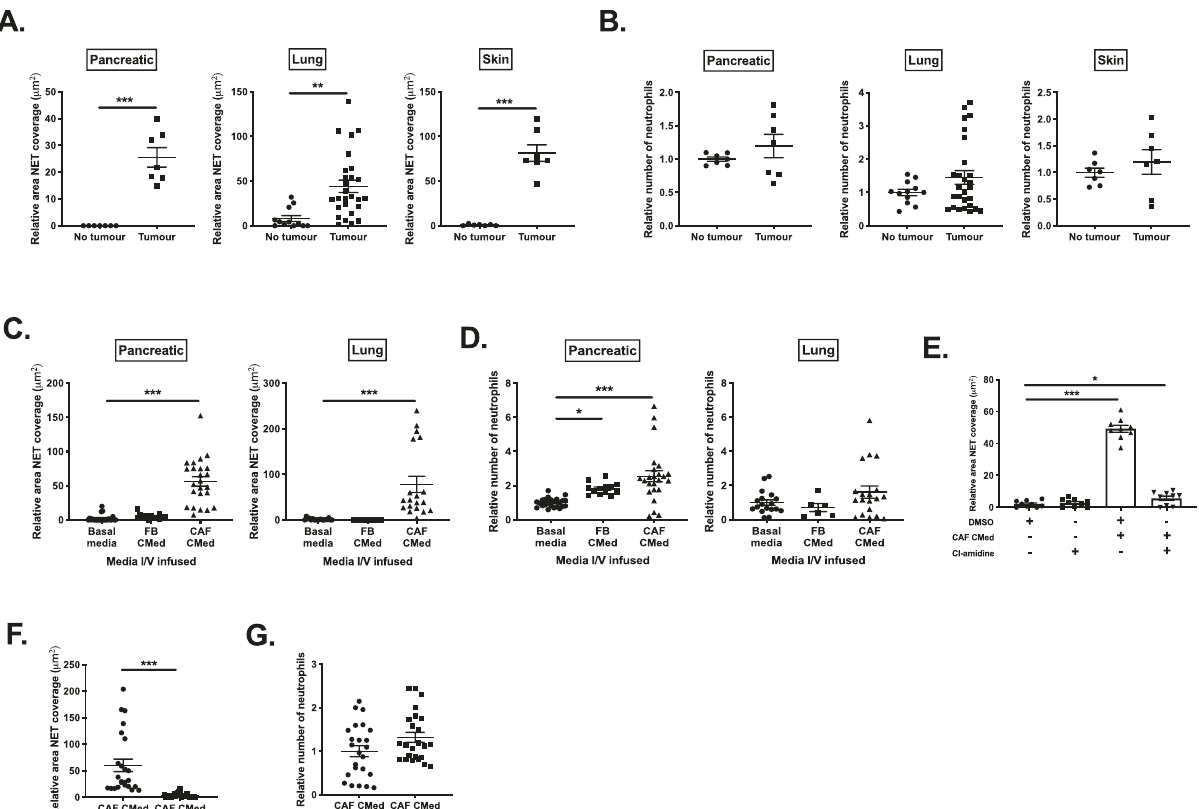
Fig. 2 CAF-derived factors drive NETosis systemically. Quanti fi cation of A relative NET coverage and B relative number of bone marrow neutrophils taken from mice with pancreatic, lung or skin tumors. Quanti fi cation of the C relative NET coverage and D relative number of bone marrow neutrophils isolated from wild-type mice intravenously infused with pancreatic or lung FB or CAF CMed 24 h before analysing NETosis. E Quanti fi cation of relative NET coverage after stimulation with pancreatic CAF CMed with or without treatment with Cl-amidine in vitro. F Quanti fi cation of the relative NET coverage and G relative number of bone marrow neutrophils isolated from mice intravenously infused with lung CAF CMed with or without pre-treatment with Cl-amidine for 24 h. Data are mean ± SEM; * p < 0.05, ** p < 0.01 and *** p < 0.001 using ( A and F ) paired t -test and C – E one-way ANOVA with a Dunnett post hoc test. Assays were performed on A – B n = 4 (in duplicate), n = 7 (in quadruplet) and n = 7 for pancreatic, lung and skin tumor-bearing mice respectively, C – D n = 8, 4 and 8 (Pancreatic for basal media, FB CMed and CAF CMed treatment, respectively. All performed in triplicate) and n = 9, 6 and 9 (Lung for basal media, FB CMed and CAF CMed treated, respectively. Performed in duplicate for basal media and CAF CMed and only a single time for FB CMed treated), E n = 3 (in triplicate) and F – G n = 8 (in triplicate) independent